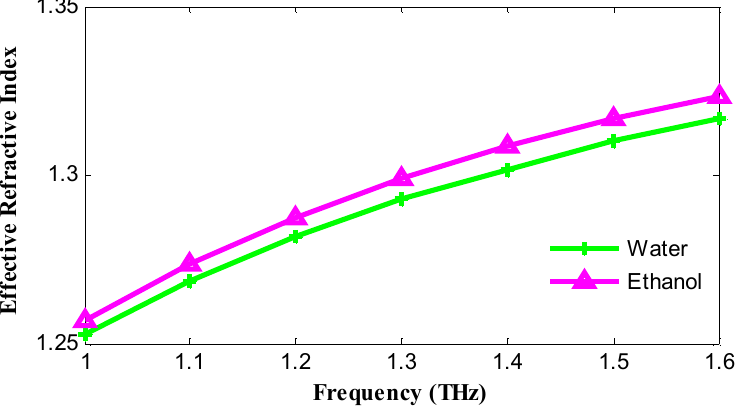
Figure 8. Effective refractive index as a function of frequency.